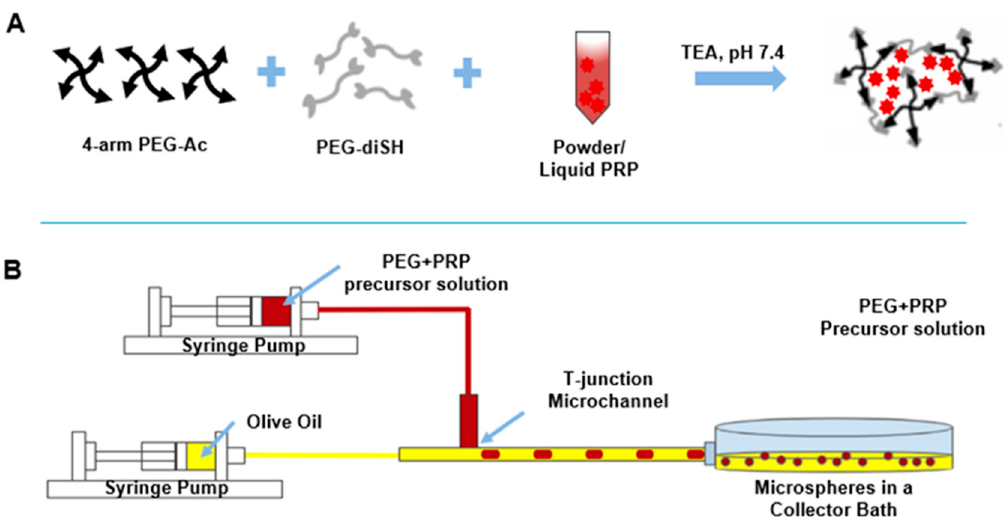
Figure 2. PRP-loaded microsphere fabrication via microfluidics. ( A ) Four-arm polyethylene glycol